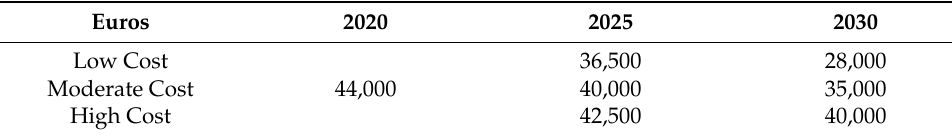
Table 6. Assumptions on the capital cost in euros of L3 Charging Stations (in euros).